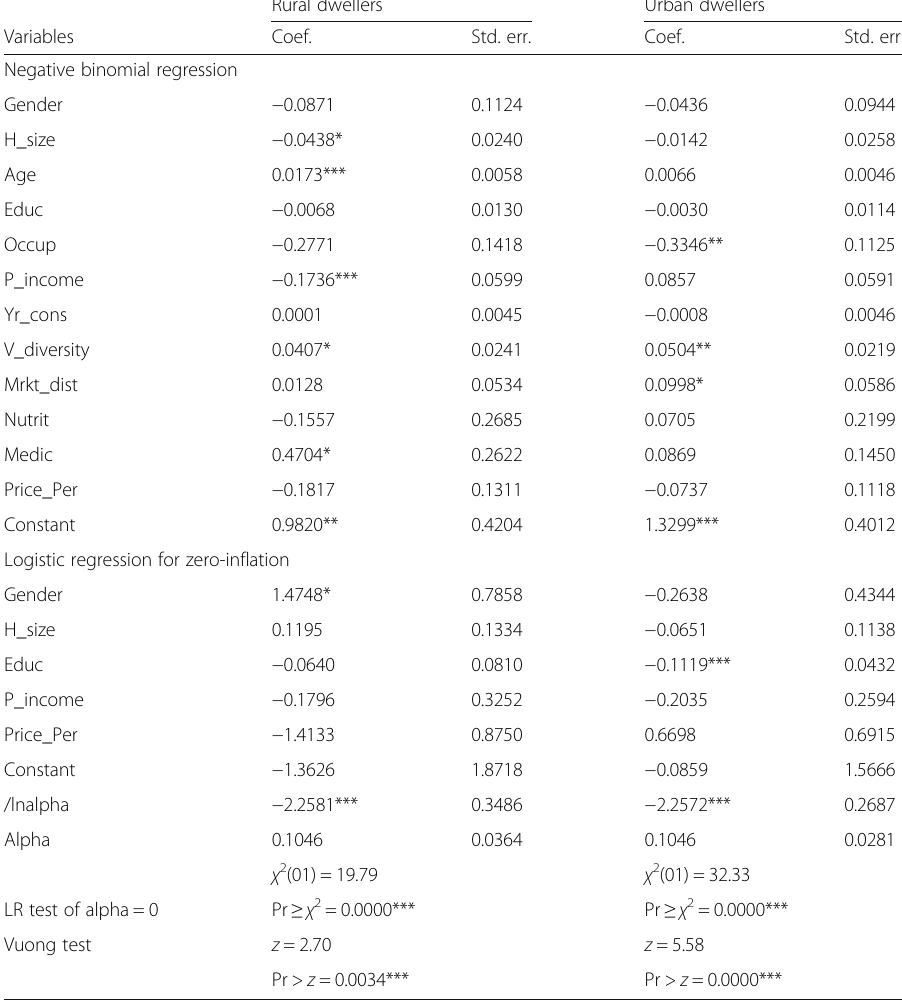
Table 3 ZINB model results on determinants of consumption intensity of leafy AIVs Rural dwellers Urban dwellers Variables Coef. Std. err. Coef. Std. err.